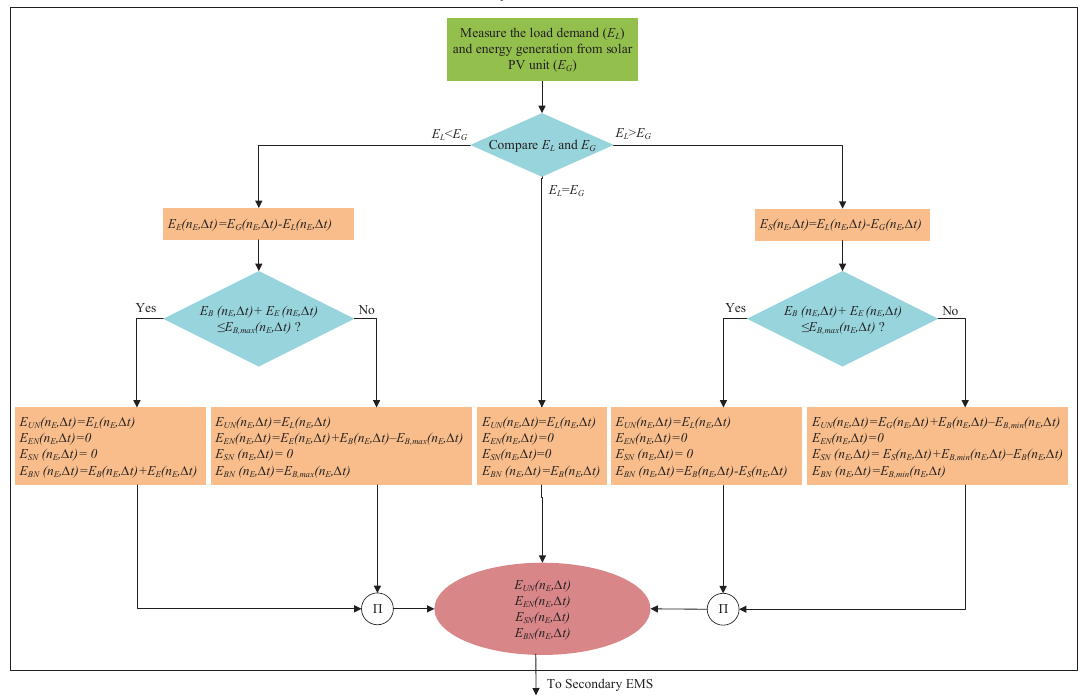
Figure 4. Energy information flow within a primary enthusiastic EMS, as well as from the enthusiastic to the secondary EMS.